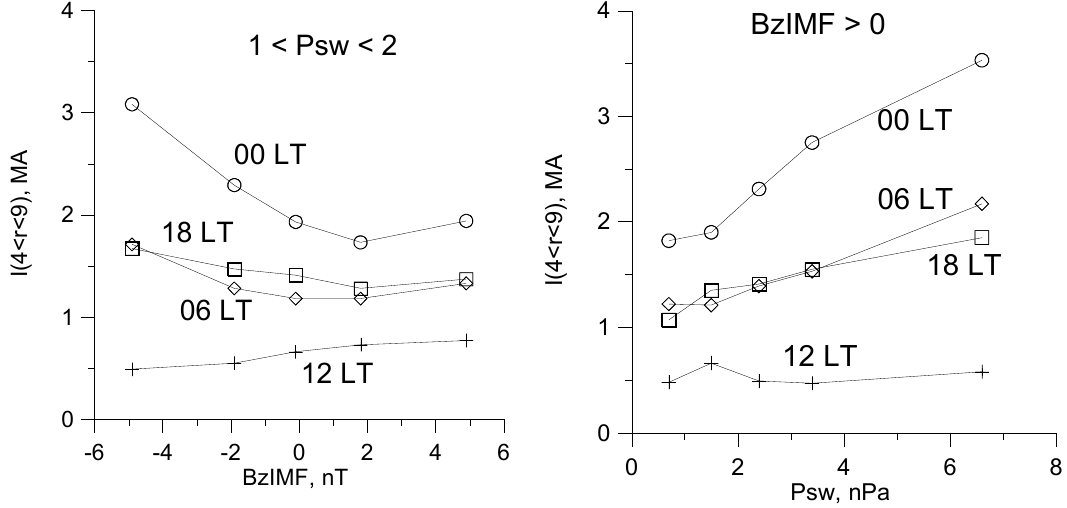
versus (left) Dst , (middle) B E